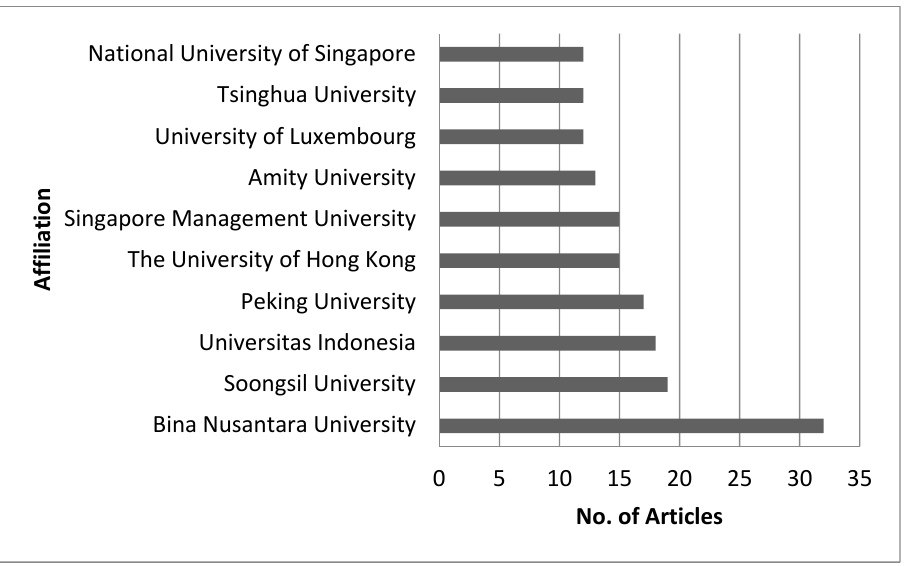
Figure 4. Most relevant affiliations.